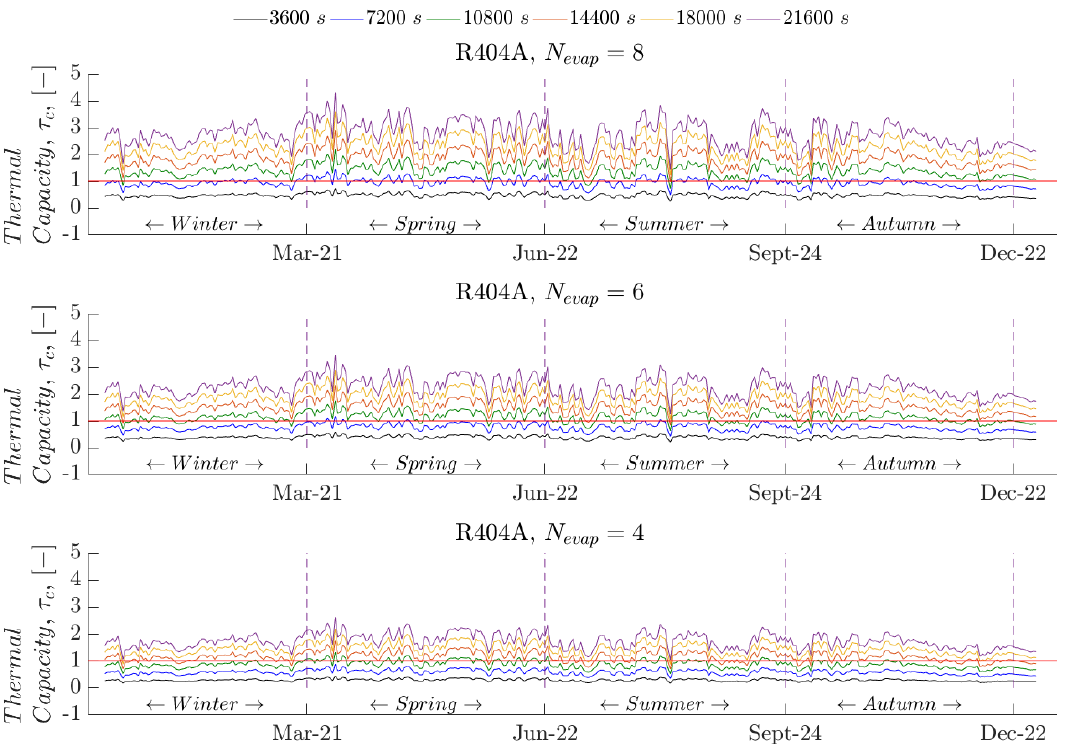
Figure 3. Thermal capacity of the heat pump during the year using R134a as working fluid.